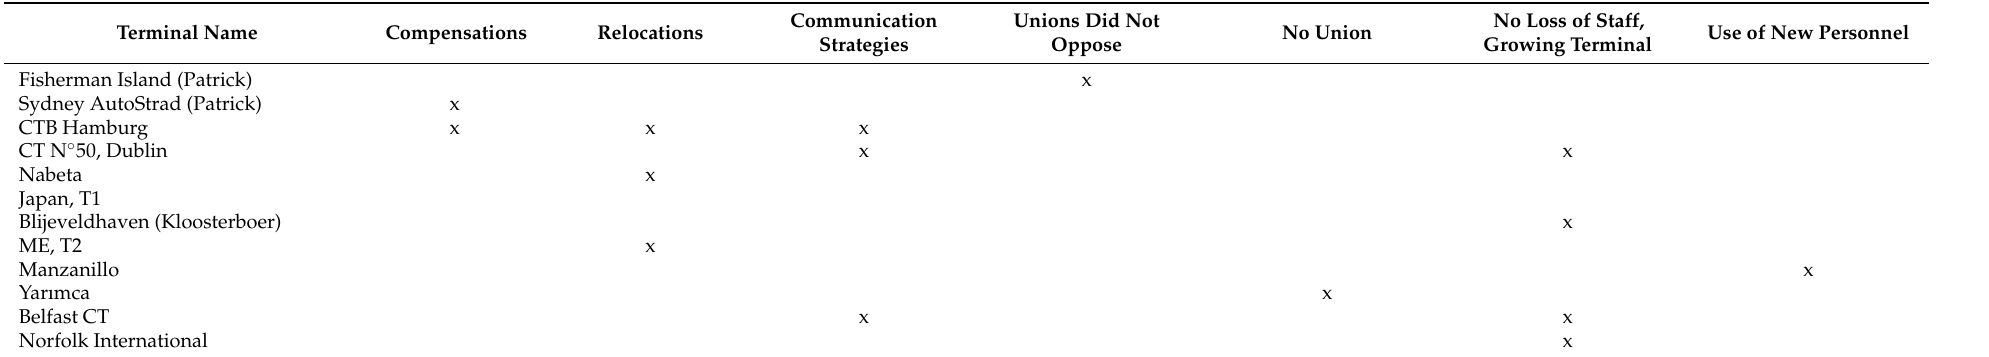
Table A4. Strategies to overcome the challenge of labor relations identified from questionnaire